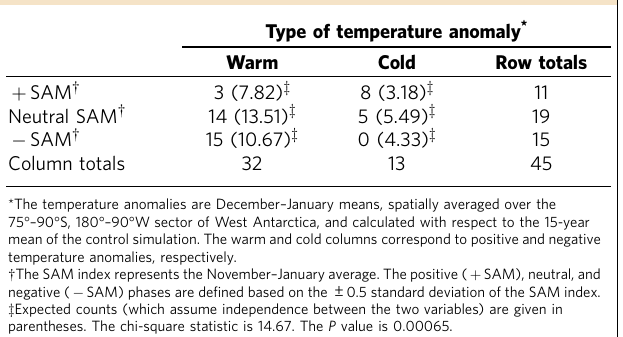
Table 1 | Contingency table tallying the count of December– January warm and cold events as a function of the phase of the November–January Southern Annular Mode in idealized CAM4 model simulations.